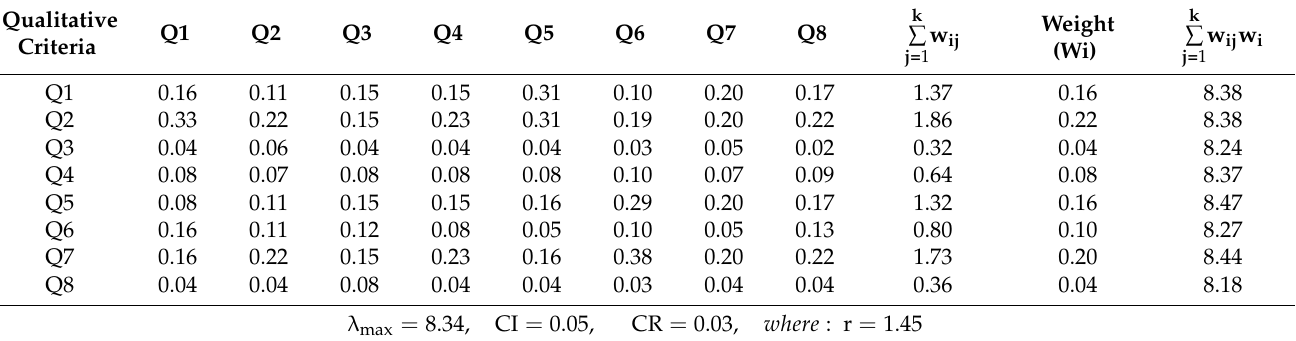
Table 10. Weights for qualitative criteria of PV. Own study.